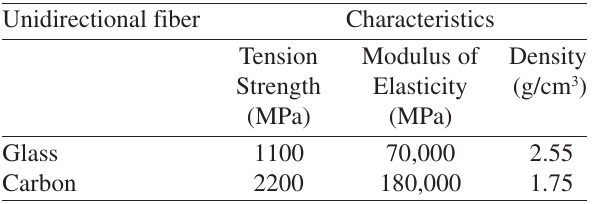
Figure 4. Position of the extensometer in the cross section of the beam. Table 2. Strength and stiffness